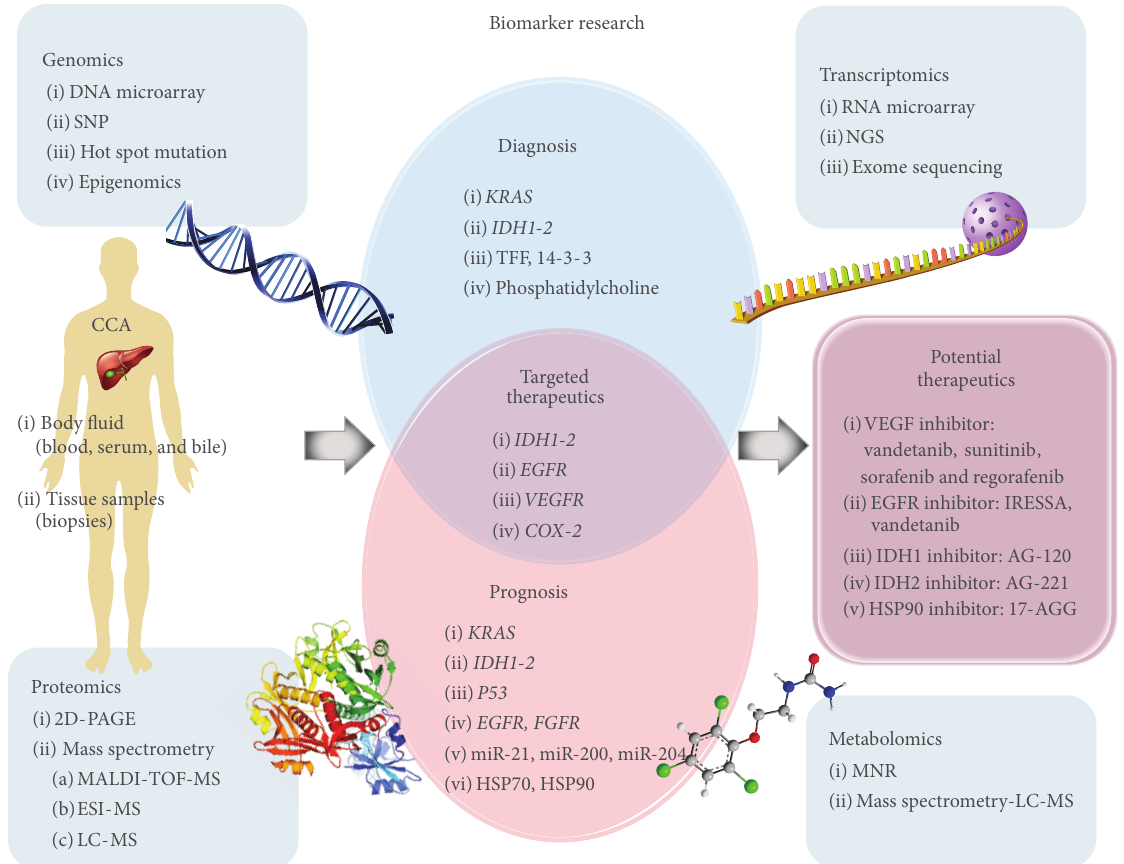
Figure 1: An overview of molecular biomarkers for CCA based on their potential use in early diagnostics, prognostics, and therapeutics. Detailed information is described in the